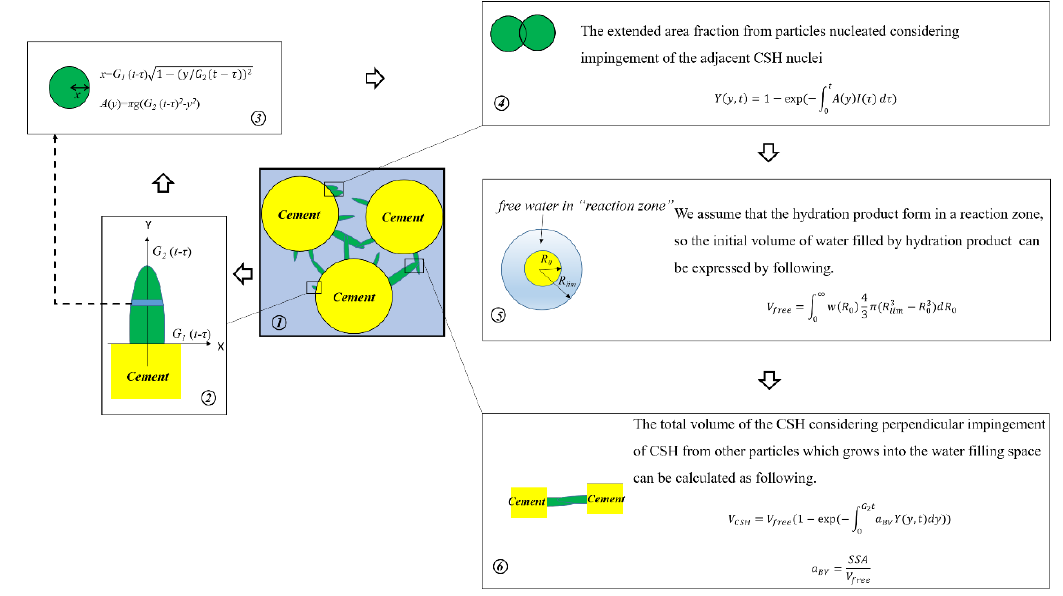
Figure 2. The schematic diagram of derivation process of nucleation and growth model.